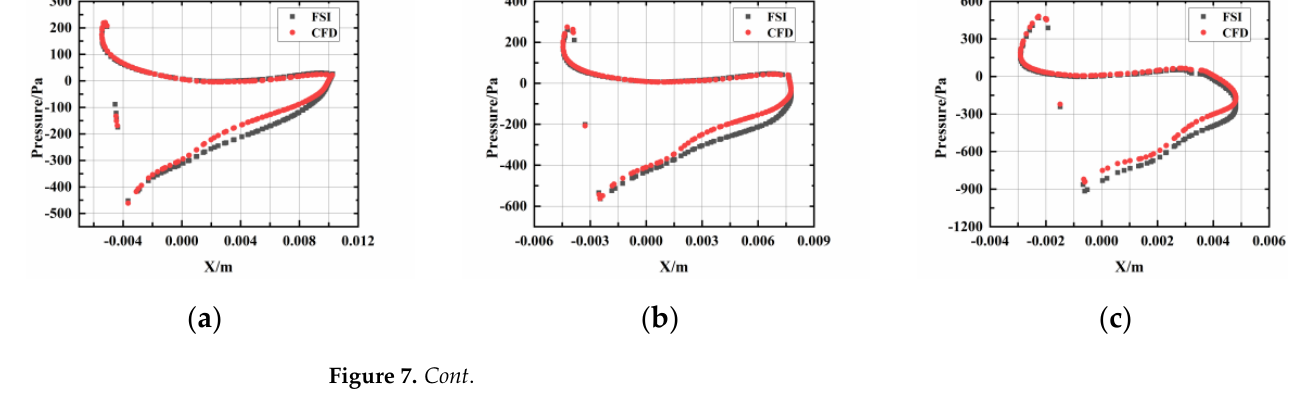
Figure 6. Graph of C p with TSR.